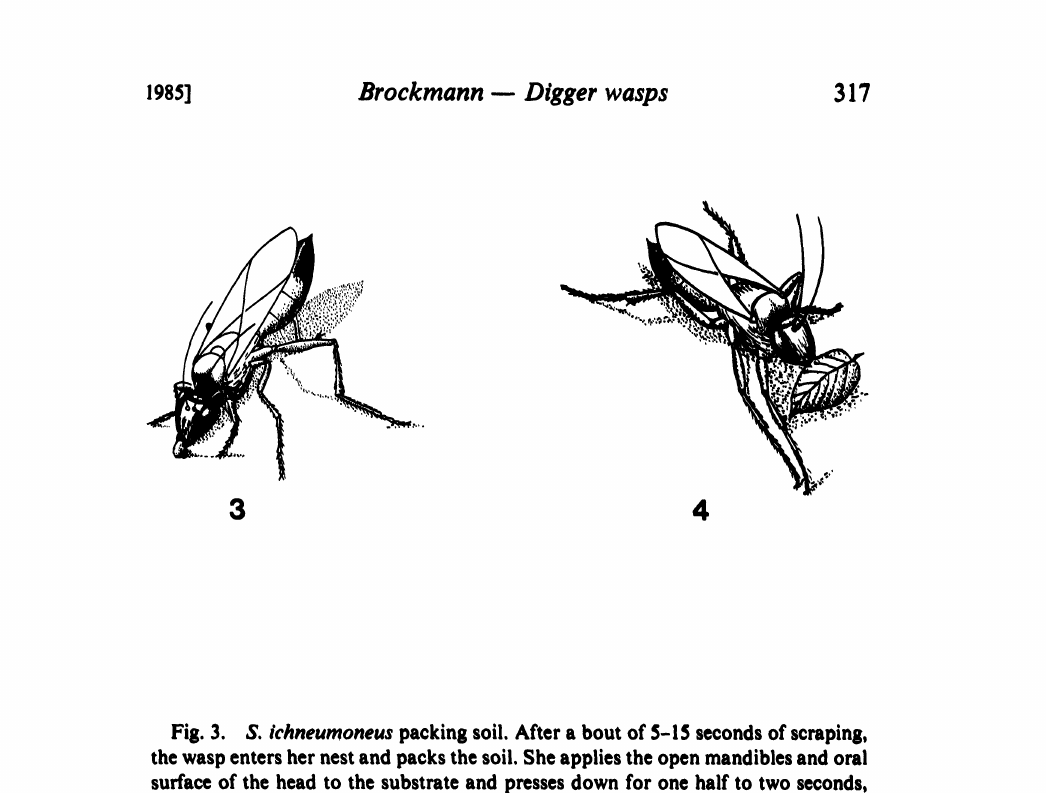
Fig. 3. 5’. ichneumoneus packing soil. After a bout of $-I 5 seconds of scraping, the wasp enters her nest and packs the soil. She applies the open mandibles and oral surface of the head to the substrate and presses down for one half to two seconds, vibrating her head and body intensely. She occasionally raises one or both hind legs above the substrate. After 5-20 sec of packing she then reemerges at the surface for another bout of scraping. Late in the filling process, when the nest fill is within cm of the surface, the wasp engages in particularly intense and prolonged packing. In addition to pressing on the fill, she also picks up stones, sticks, clods of dirt, or other pieces of debris, carries it to the nest in her mandibles and presses it down into the soil (seen here). Clods of dirt usually disintegrate, whereas stones and debris are either left in place or occasionally picked upand discarded. On rare occasions wasps have been observed to use the same object several times as a compacting tool. 5’. pensylvanicus shows similar packing behavior. Fig. 4. 5’. ichneumoneus disguising the nest entrance. The wasp scrapes the region around the nest many times. Leaves, sticks and other debris are grasped with the mandibles and either pulled (seen here) over or pushed to the nest entrance or just picked up and moved to another location around the nest. The effect of this is that the exact location of the entrance is impossible to detect either by the degree of compaction of the soil or by the appearance of the area around the nest. 5,phex pensylvanicus often chews around the nest entrance, breaking down the sides of the burrow and leaves a wide depression at the site of the nest